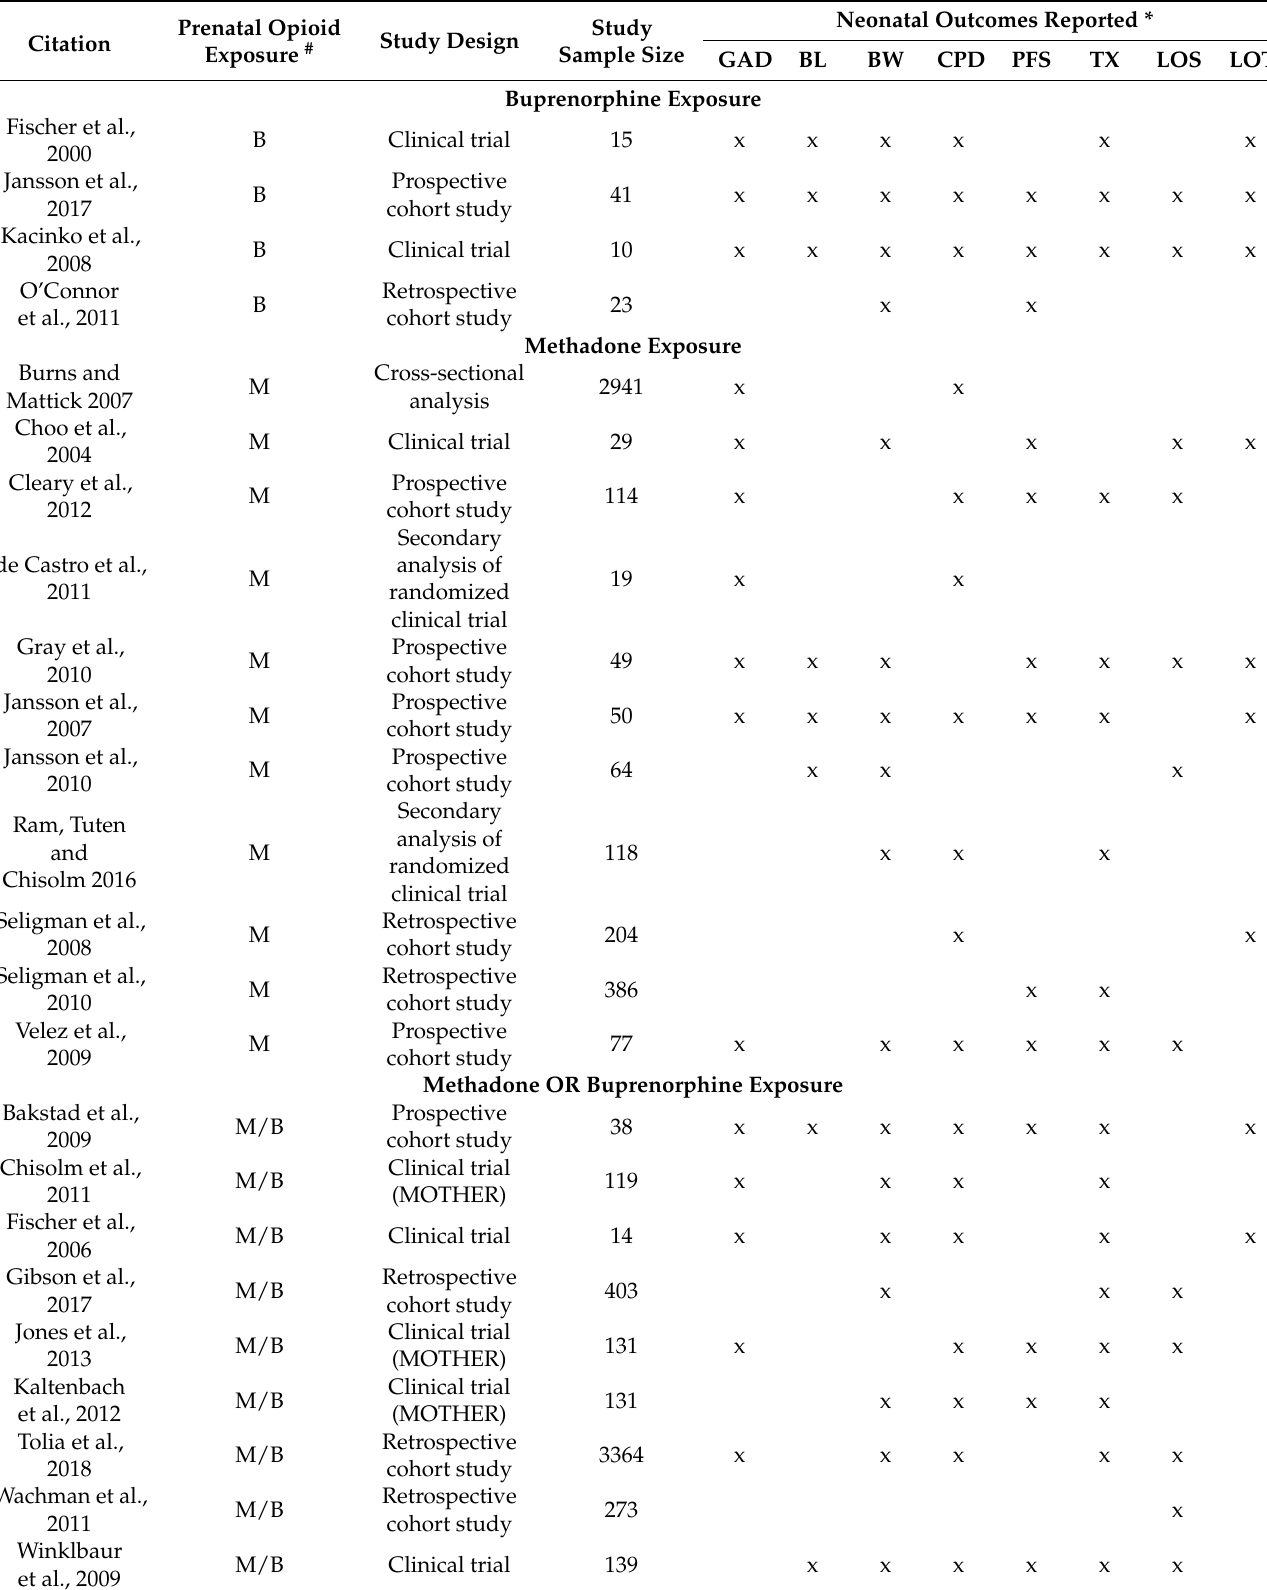
Table 1. Study design and outcomes